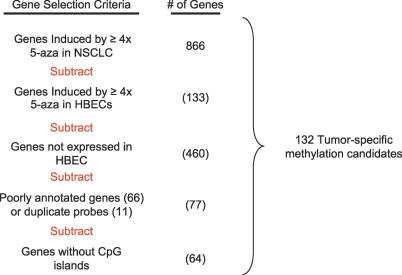
Strategy Used to Identify Methylation Candidates by Gene Expression MicroarrayNSCLC and HBEC lines were treated with 5-aza and compared to controls (DMSO). We subtracted transcripts induced at least 4-fold in HBEC (n = 133) from the total number induced at least 4-fold in two of seven NSCLC lines (866 loci of 47,000 total), since methylation of these genes is unlikely to be tumor specific. For practical purposes we removed genes that were not expressed in HBEC (n = 460), were duplicate probes (n = 11), or had poor annotations (n = 66). Finally we excluded genes without identifiable 5′ CpG islands (n = 64). The number of genes subtracted from the total induced ≥4-fold in two of seven NSCLC cell lines (n = 866) is indicated next to each description in parentheses. We used the percentage of transcripts associated with 5′ CpG island as a measure of enrichment for the major steps in the filtering process. 37% of all RefSeq transcripts contain 5′ CpG islands; 55% of the 866 5-aza–induced transcripts had 5′ CpG islands; 73% of the final 196 genes had CpG islands. Statistical analysis of these data appears in Table 5.